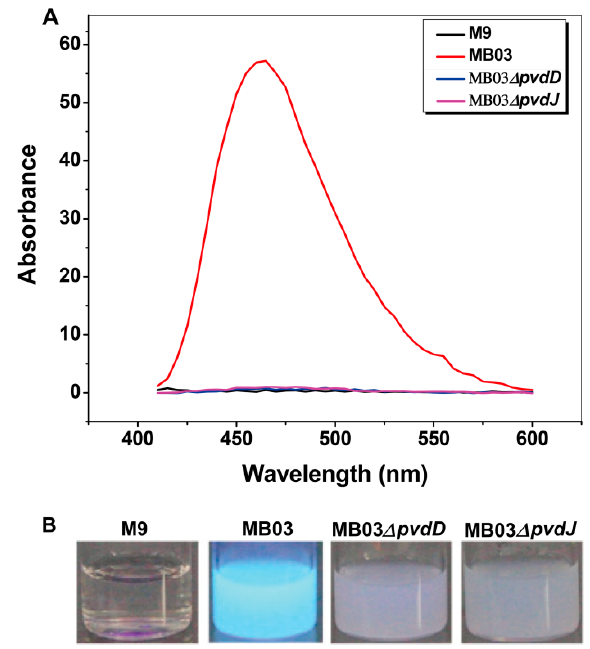
Figure 3. PVD production in P. syringae MB03 and the mutants MB03 ∆ pvdD and MB03 ∆ pvdJ : ( A ) Wavelength-scanning curves of the supernatants from the ∆ pvdD and ∆ pvdJ mutant strain culture suspensions and ( B ) fluorescence of P. syringae MB03, MB03 ∆ pvdD , and MB03 ∆ pvdJ cell suspensions. M9 was used as the negative control.